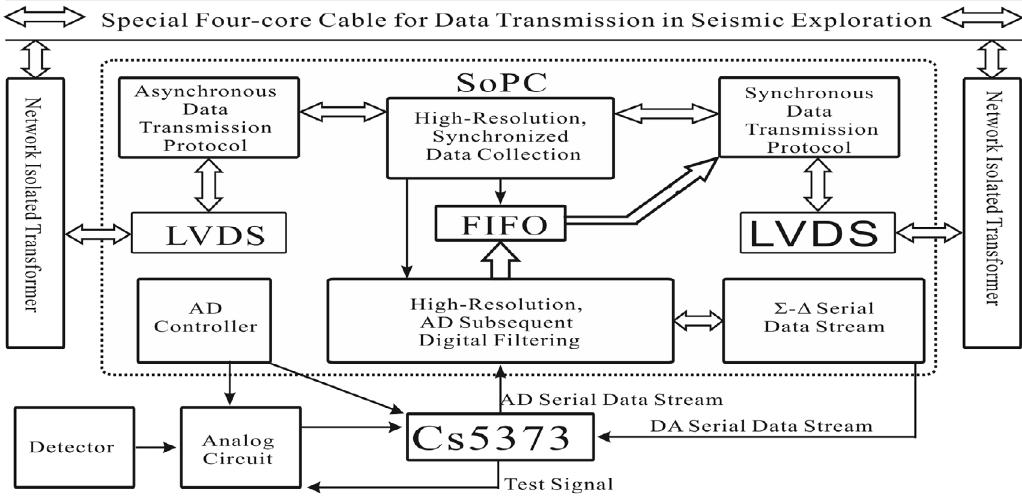
Figure 2. The overall structure of the data-acquisition station with the CS5373 subsequent digital filter, which was independently